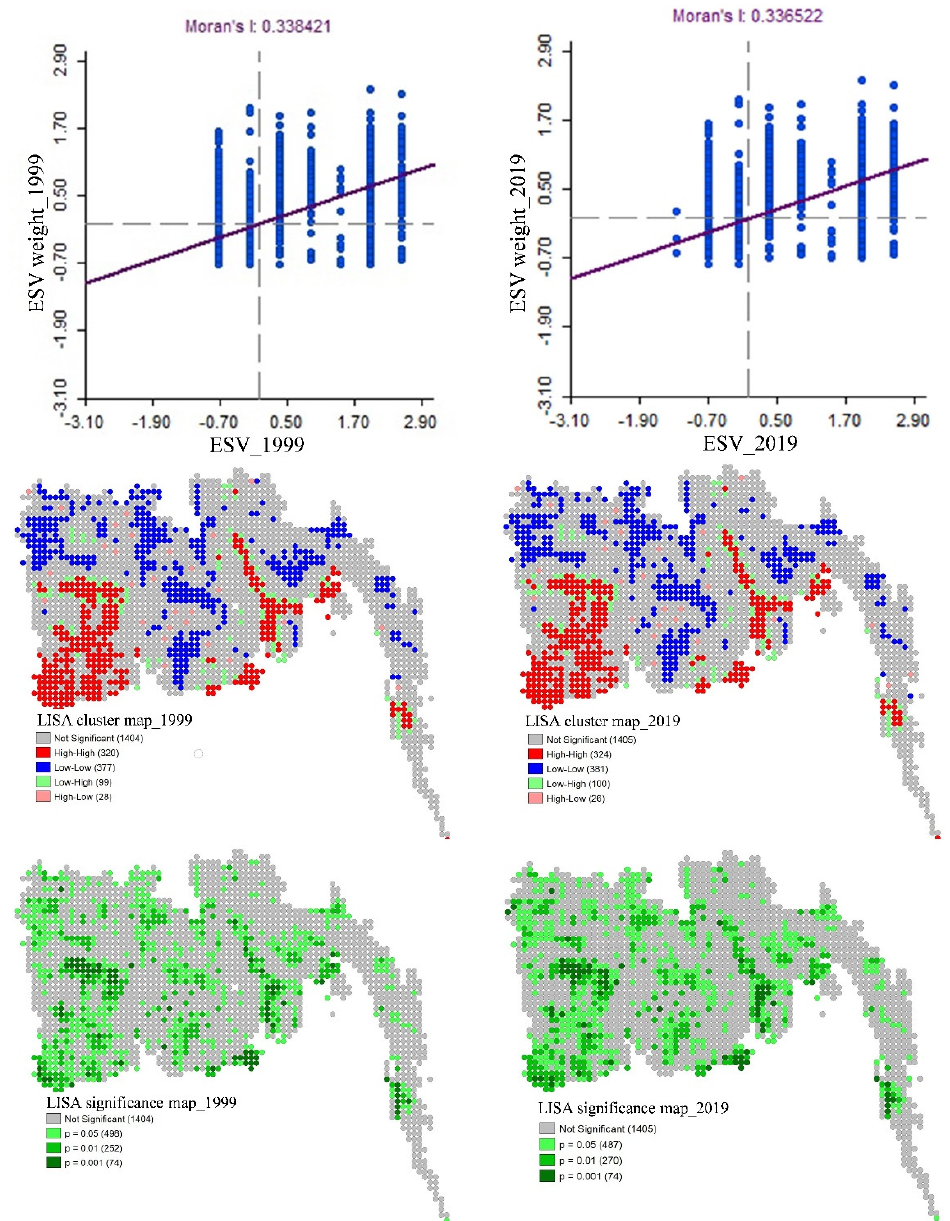
Figure 7. Spatial autocorrelation results showing Moran’s I, LISA cluster map, and LISA significance map of 1999 and 2019 in CRB.